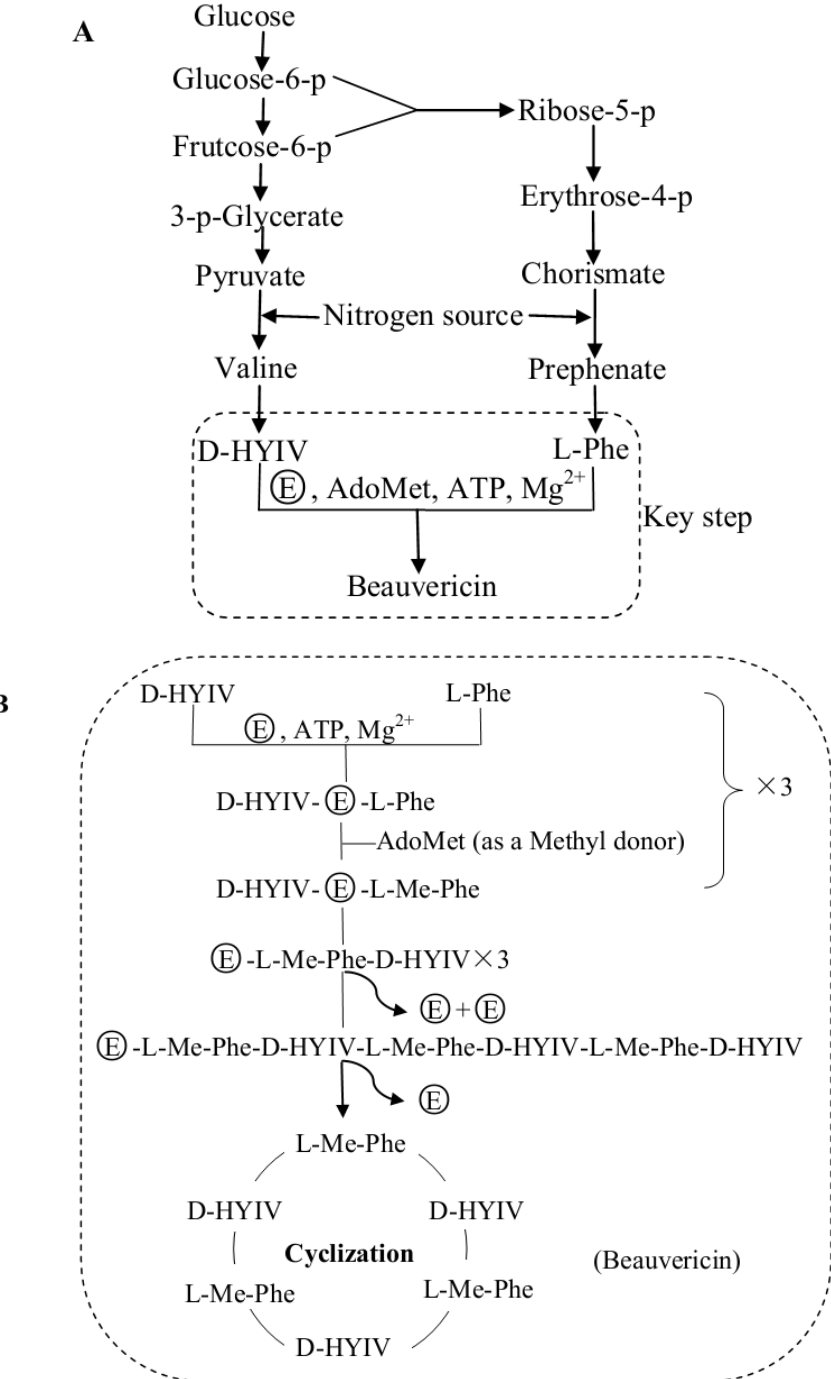
Figure 3. A , Beauvericin biosynthesis pathway; B , The specific substeps of the key step ○ ( E represents the beauvericin synthetase; the dashed frame indicates the key step of beauvericin synthesis); C , The possible structure of the beauvericin synthetase (E D -HYIV module; E 2 is the L -Phe module; SH 1,2,3 are the 4'-phosphopantetheine residues corresponding to D -HYIV, L -Phe, and the linear hexadepsipeptide acceptor; M is the N-methyltransferase domain; Cy is the cyclization